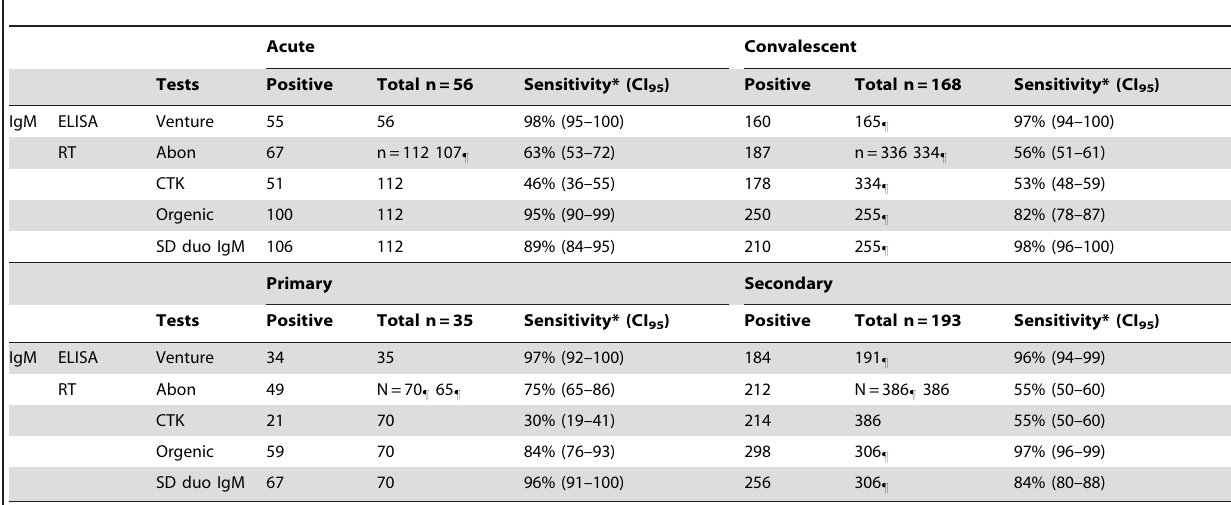
Table 6. Sensitivity of anti-DENV IgM compared to IgM reference test in acute and convalescent samples.